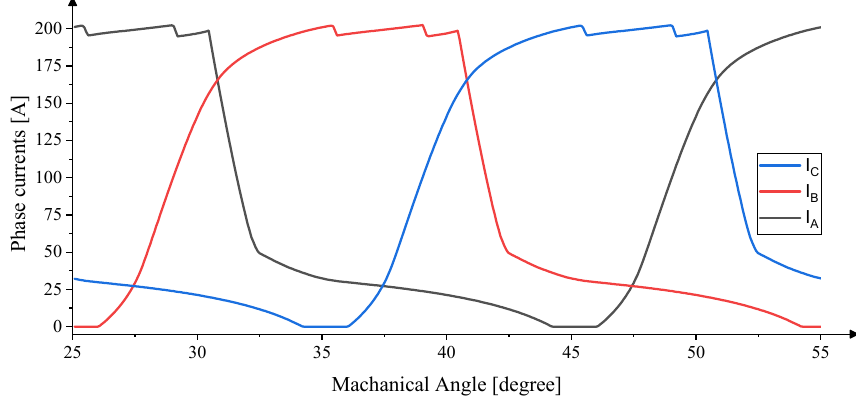
Figure 23. Dynamic phase current waveforms of LSA SRM at 2600 rpm.